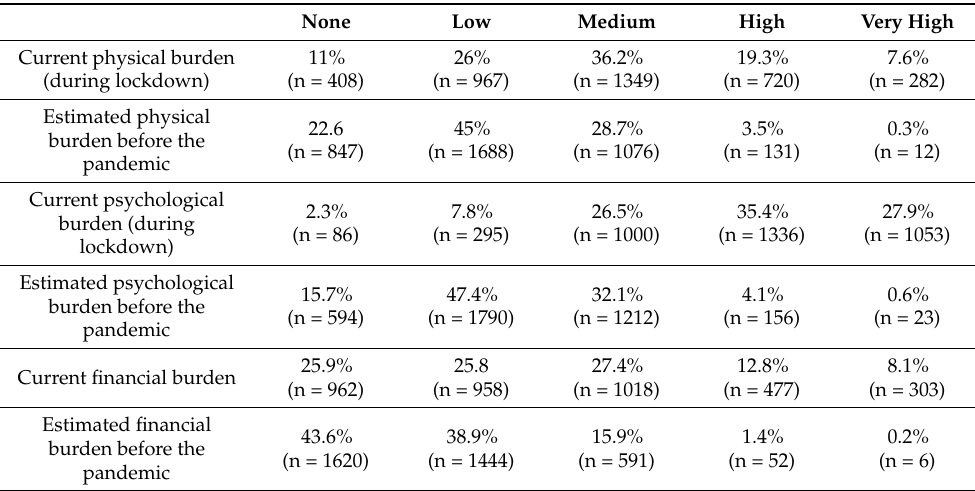
Table 4. Physical, psychological, and financial burden of working parents during the current lock- down and before the